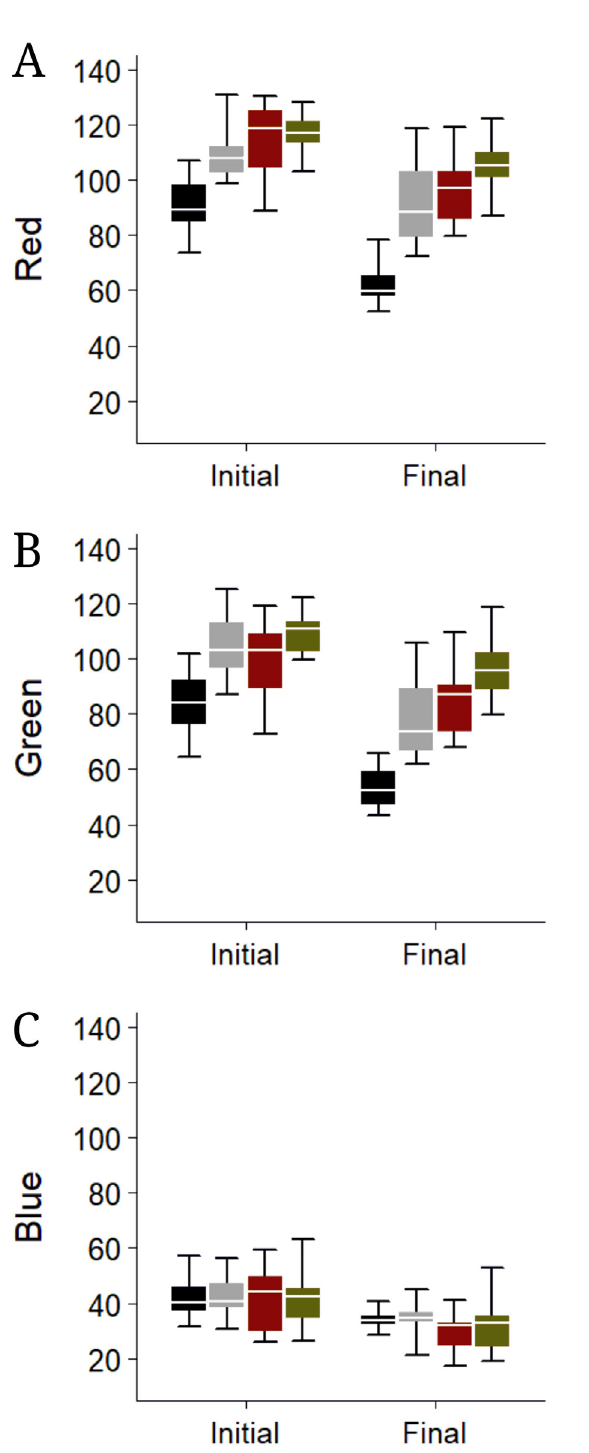
FIGURE 5 | Raw values of RBG; A. Red, B. Green and C. Blue measurements of Crenuchus spilurus body color during the beginning (Initial) and end (Final) periods of the trials. Black and grey boxes represent populations from the Negro lineage; red and brown represent populations from the Amazonas